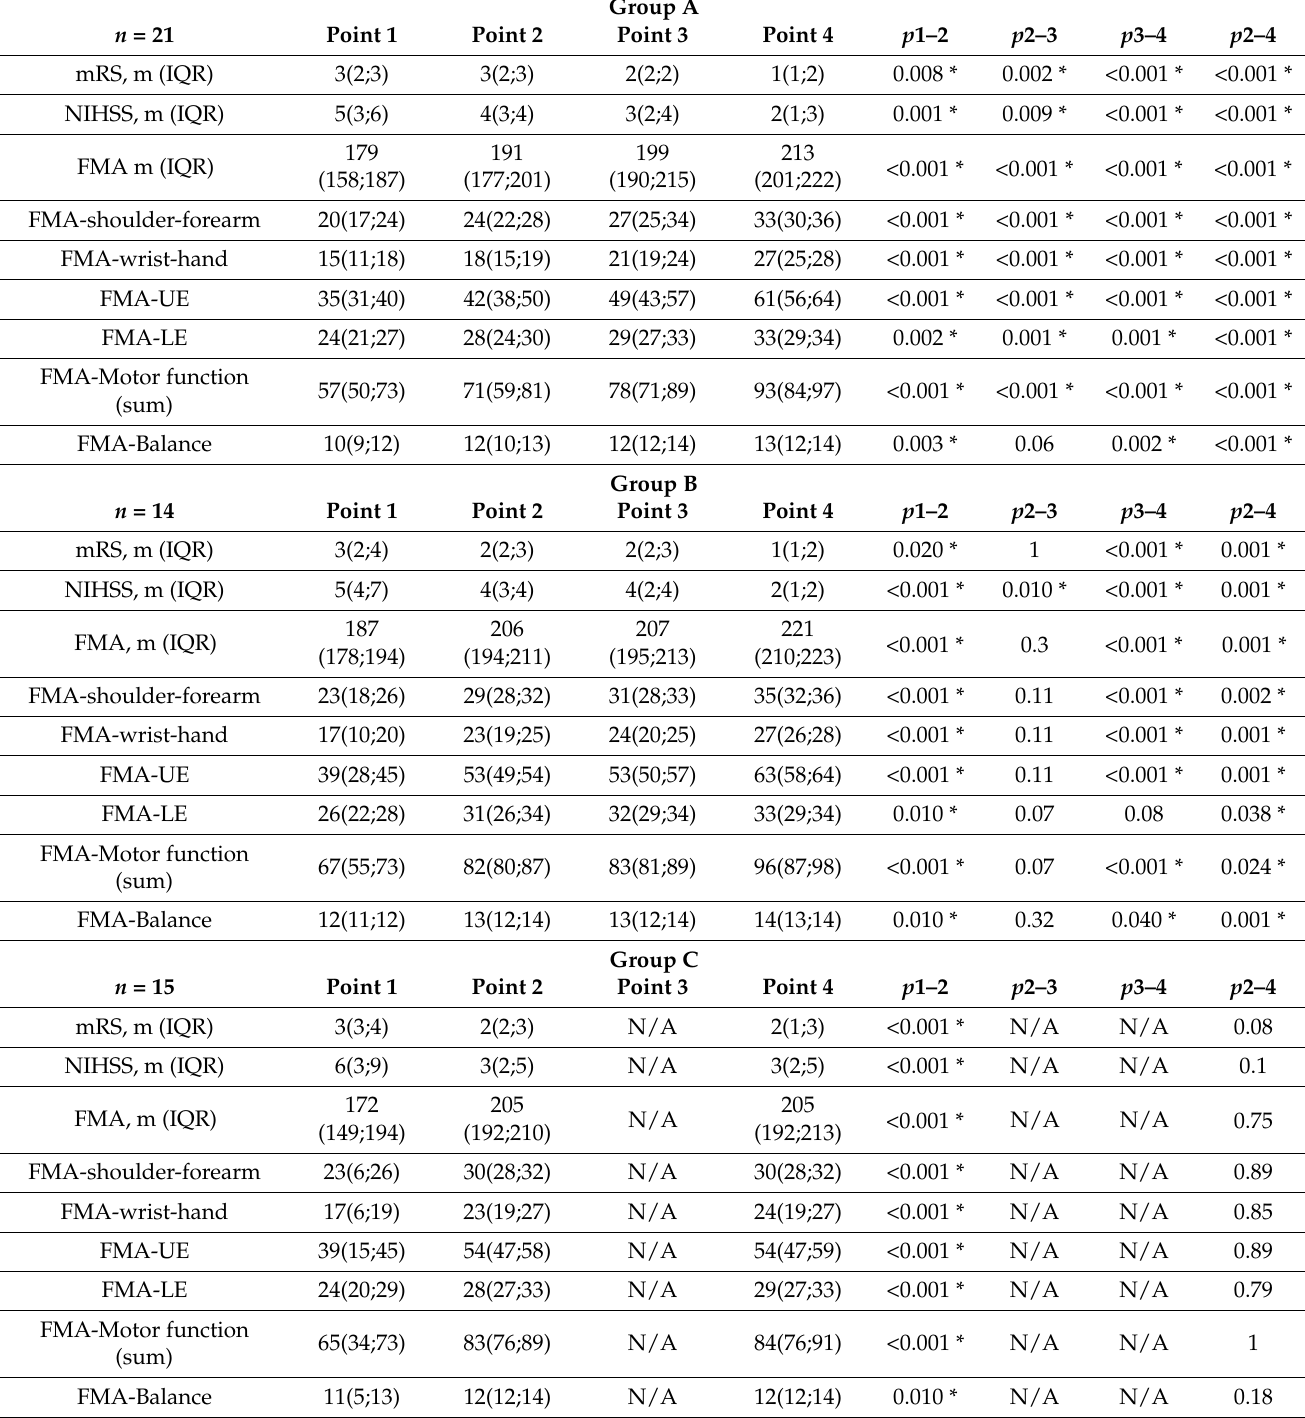
Table 3. Comparison between groups of patients who received rehabilitation in the early recovery period of ischemic stroke. Group